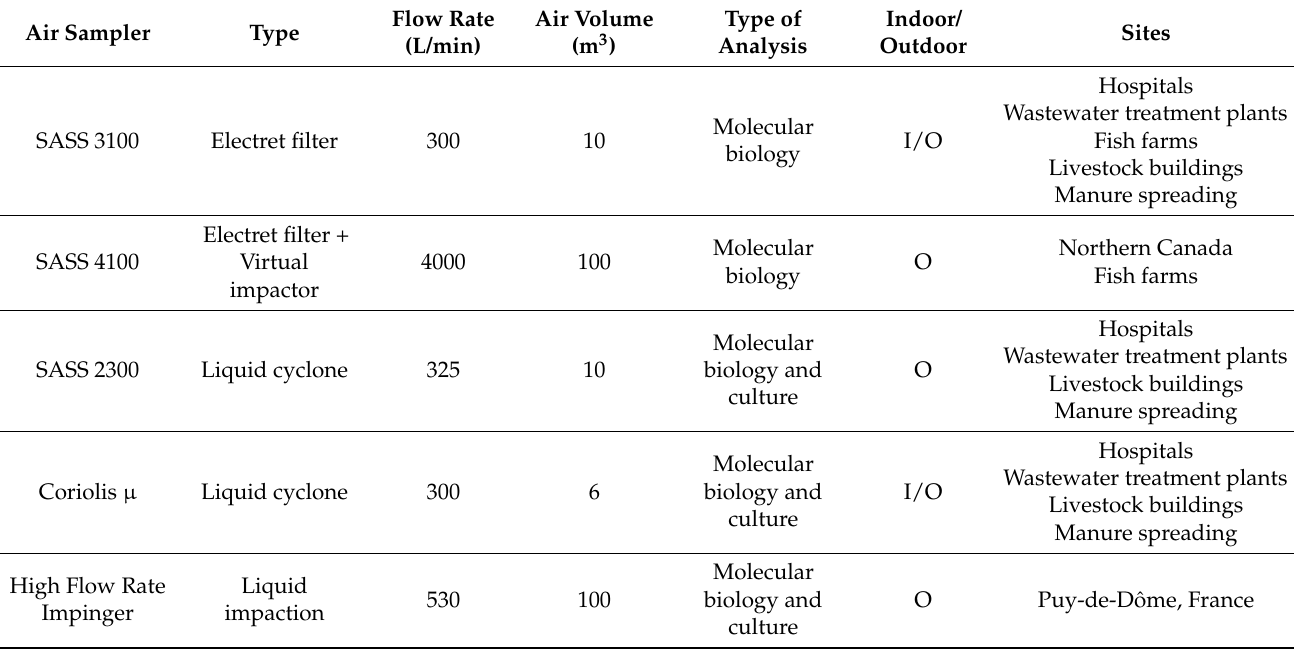
Table 2. Air extractors selected for aims 2 and